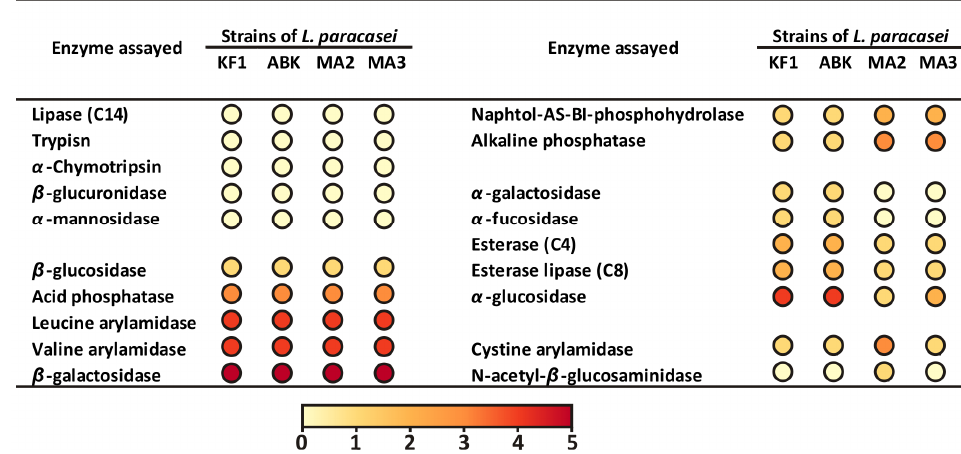
Figure 3. The API ZYM enzymatic activity profiles of kefir-derived (KF1 and ABK) and mahewu- derived (MA2 and MA3) strains of L. paracasei . The data for the kefir-derived strains were obtained from Begunova et al. [31].